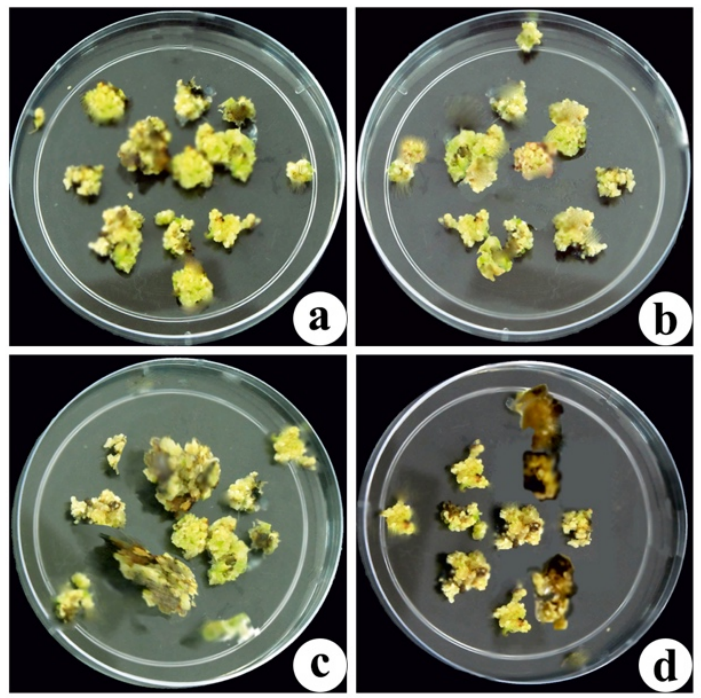
Figure 3. Antibiotic sensitivity of calli cultured on MS + 0.2 mg/L 2,4-D medium supplemented ( a ) without (0 mg/L) and with ( b ) 10 mg/L; ( c ) 20 mg/L and ( d ) 50 mg/L kanamycin.